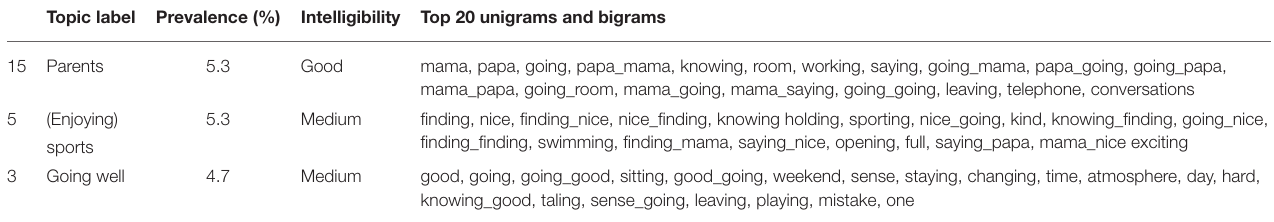
TABLE 6 | Three most frequently occurring LDA topics and the top 20 words in the